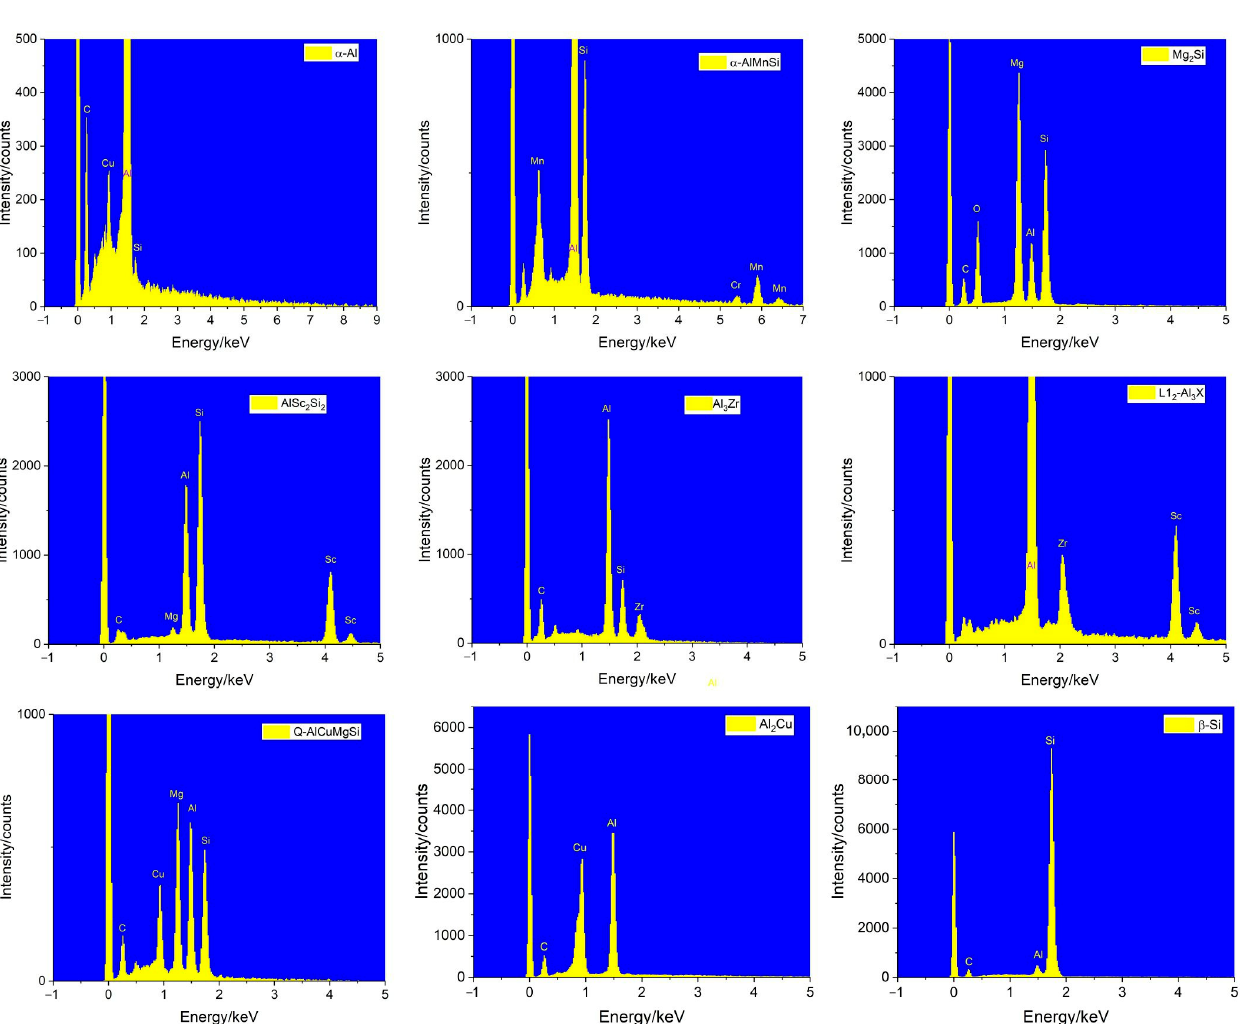
10 of 21 Figure 6. XRD patterns of the investigated alloys in the ( a ) as-cast condition, ( b ) after DSC, and ( c ) after homogenisation.